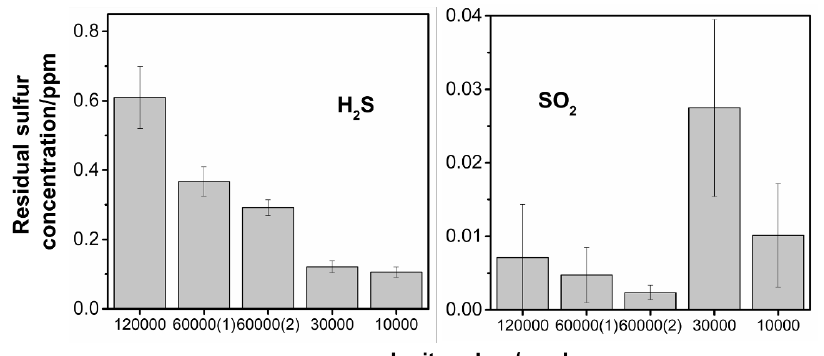
Figure 3. Residual sulfur concentrations measured under various space velocities with sorbent 15Mn8Mo at 600 °C with the gas composition 0.2, 19.8, 40.0, and 40 vol.% for H 2 S, Ar, H 2 , and N 2 (2000 ppm H 2 S). The two tests with 60,000 mL gas /g sorbent h are conducted with two loading amounts of sorbents, i.e., 0.1 g (test 1) and 0.2 g (test